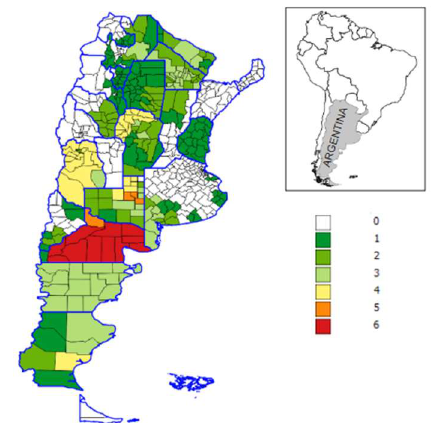
Figure 1. Number of drought emergencies declared (at the department scale). Blue lines represent Province limits. Black lines represent Department limits.